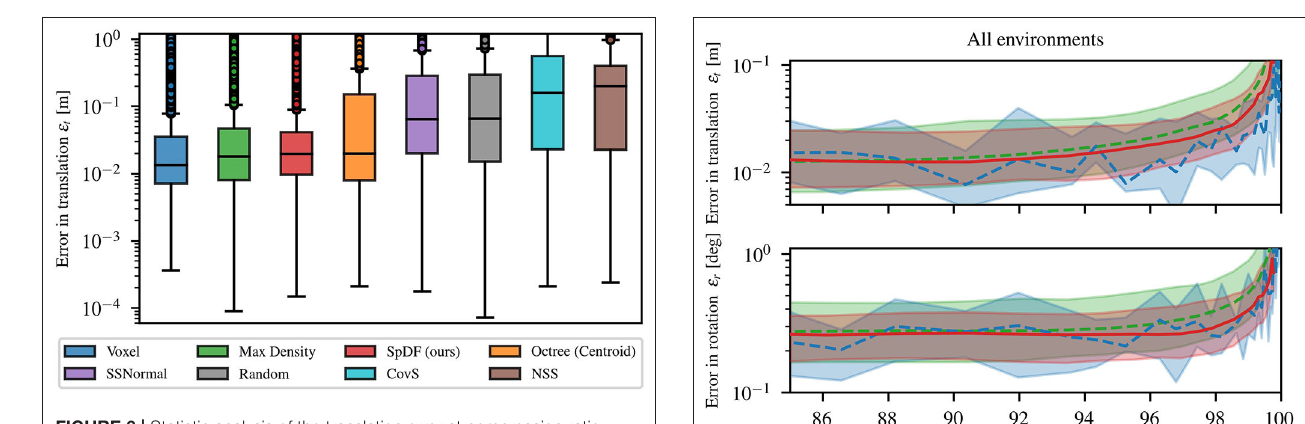
FIGURE 6 | Statistic analysis of the translation error at compression ratio between 0 and 99.9 % for each method, graphically represented as box plots. Medians are given with their first Q 1 and third Q 3 quartiles. The spacing between the different parts of the box indicate the degree of dispersion (spread) and skewness in the errors. Boxes are given with whiskers with FIGURE 7 | Comparison of Voxel , MaxDensity , and SpDF (ours) influence Q 3 Q 1 is the inter-quartile range. We can maximum 1.5 IQR, where IQR = − of the number of points on the registration process for high compression clearly identify two clusters of solution: (1) Voxel , MaxDensity , and SpDF ; ratios. The top-graph represents the median error in translation ε t in m. The and (2) SSNormal , Random , CovS , and NSS . The Octree method is bottom-graph represents the median error in rotation ε r in deg. Both errors are in-between as the spread extends from the first to the second cluster. displayed with their quartiles at 25 and 75 %. All method errors are of the same magnitude and can be considered equivalent. However, SpDF is slightly more stable as the compression rate grows compared to Voxel . We can expect a compression ratio of 97 % without hindering the registration process for all of these methods, i.e., ε t < 2 cm and ε r < 0.3 ◦